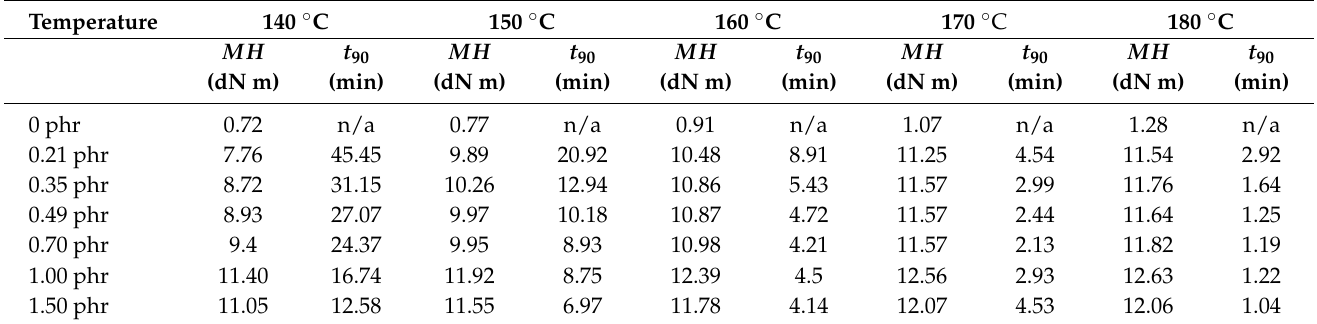
Table 2. Curing parameters for silicone rubber compounds concerning maximum torque ( MH ) and opti- mum cure time ( t 90 ) for different crosslinking temperatures and varied dicumylperoxide